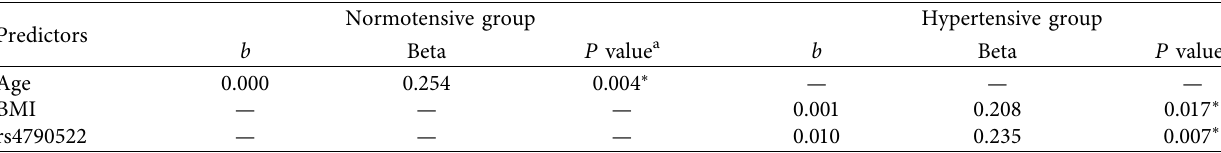
Table 6: Variables associated with salt recognition thresholds among normotensive and hypertensive groups using the multiple linear regression